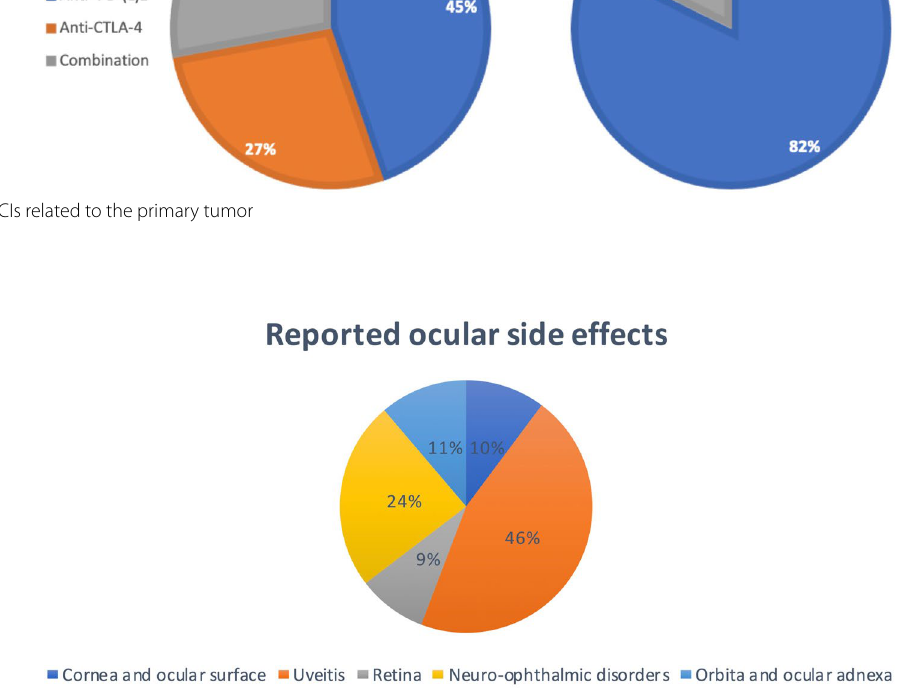
Fig. 4 Reported ocular side effects